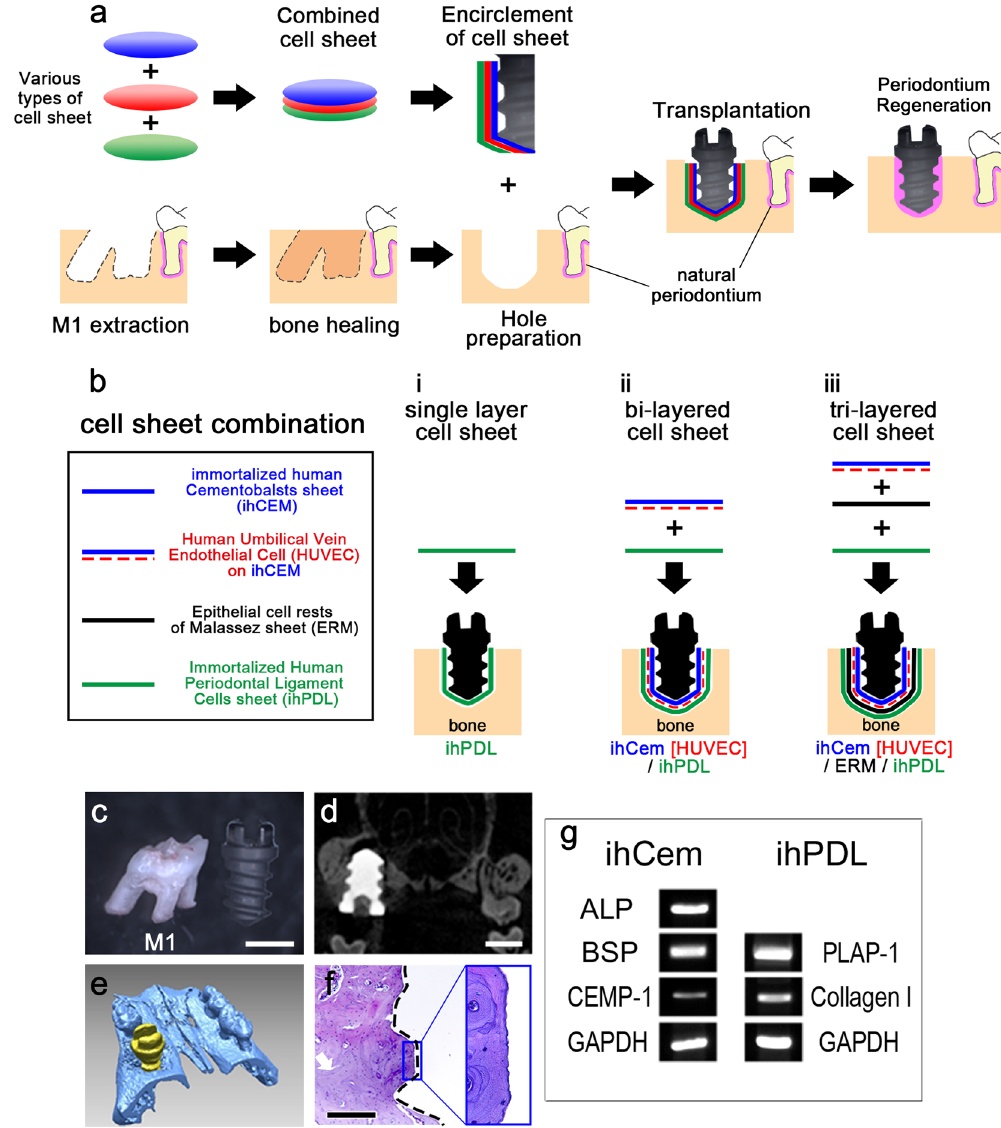
Figure 1. Transplantation of a bio-implant in a tooth extraction model and characteristics of the immortalized human cells. ( a ) Schematic representation of the bio-implant procedure. The main purpose of this study is periodontium regeneration around implant fixture. ( b ) Combination of cell sheets used in this study. Various types of cell sheet (panel a) are described. ( c ) Maxillary first molar and HA-coated dental implant fixture. ( d ) Micro CT image of 8 weeks after transplantation of the HA-coated fixture shows the alveolar bone compactly healed around the fixture. ( e ) 3D reconstruction of the micro CT results at 8 weeks after transplantation of the HA-coated fixture. ( f ) HE-stained image at 8 weeks after transplantation of the HA-coated fixture showing osseointegration between the alveolar bone and the fixture. Black dashed line shows the margin of the removed implant fixture. ( g ) RT-PCR results of immortalized human cells (cropped gel image). The ihCEMs expressed ALP, BSP and CEMP-1. The ihPDLs expressed PLAP-1 and ColI. Full-length gel is presented in Supplementary Figure 6. Scale bars, ( b , c ) 1 mm; ( e ) 200 μ